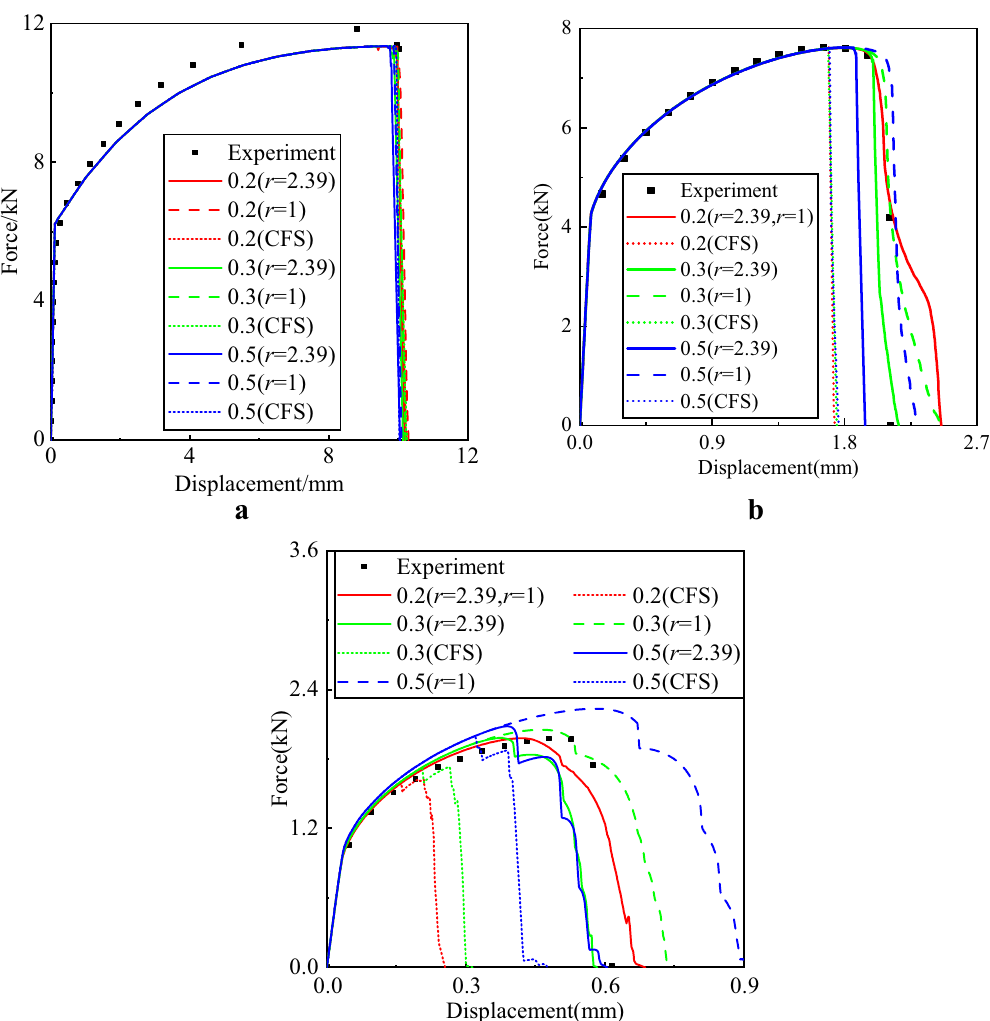
Figure 4 The force–displacement curves of three specimens: a ST specimen, b N–R10 specimen and c N–45